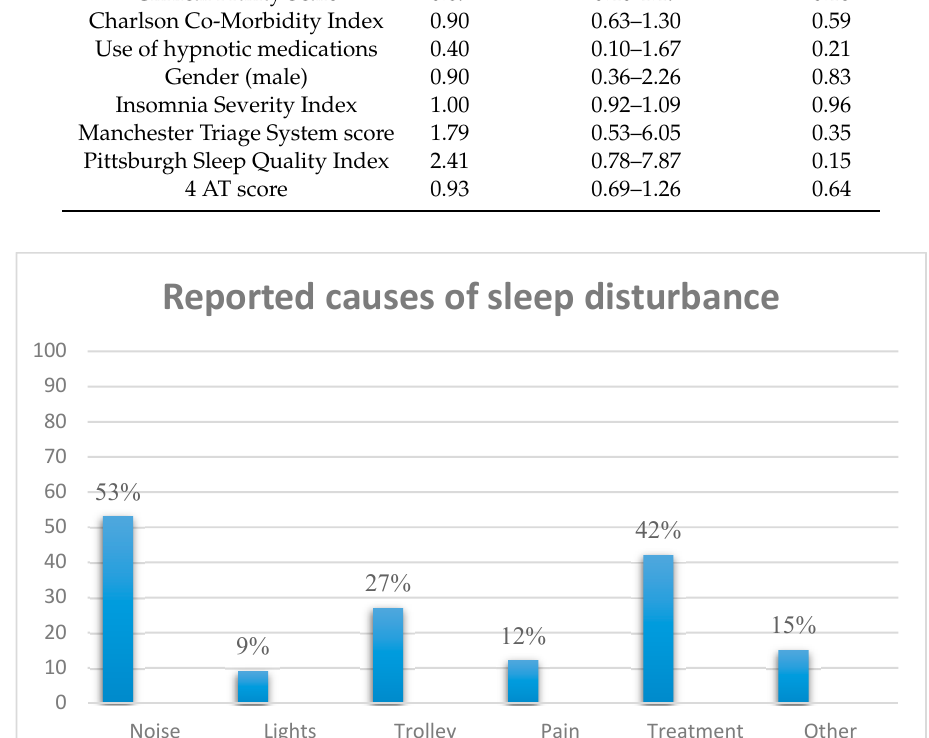
Figure 3. Self-reported causes for sleep disturbance for patients boarding overnight in the emergency department.